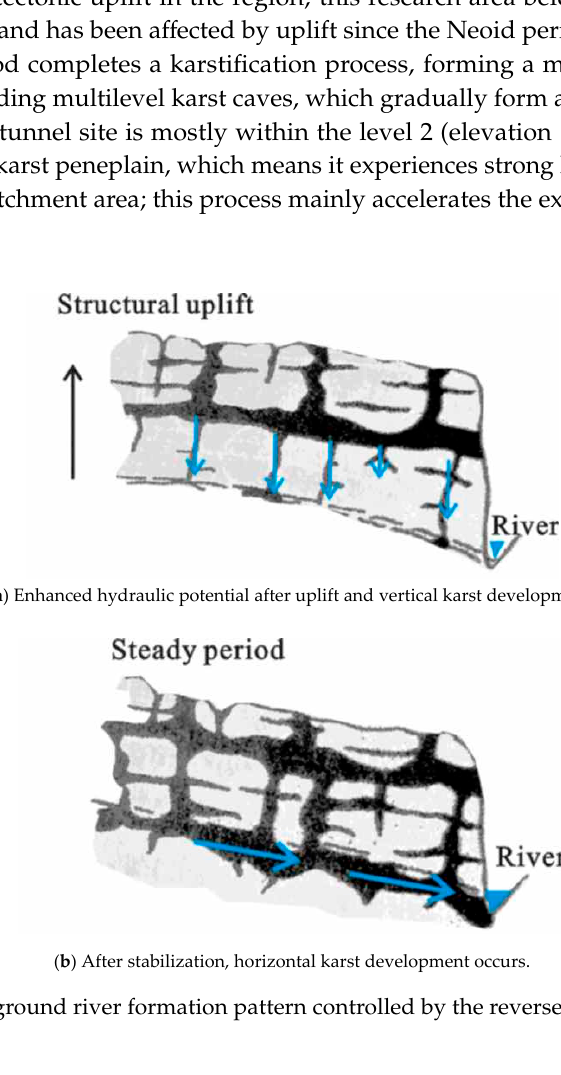
Figure 5. Typical outburst development in a typical strong karst area in the tunnel site and site survey in the corresponding section of the tunnel.